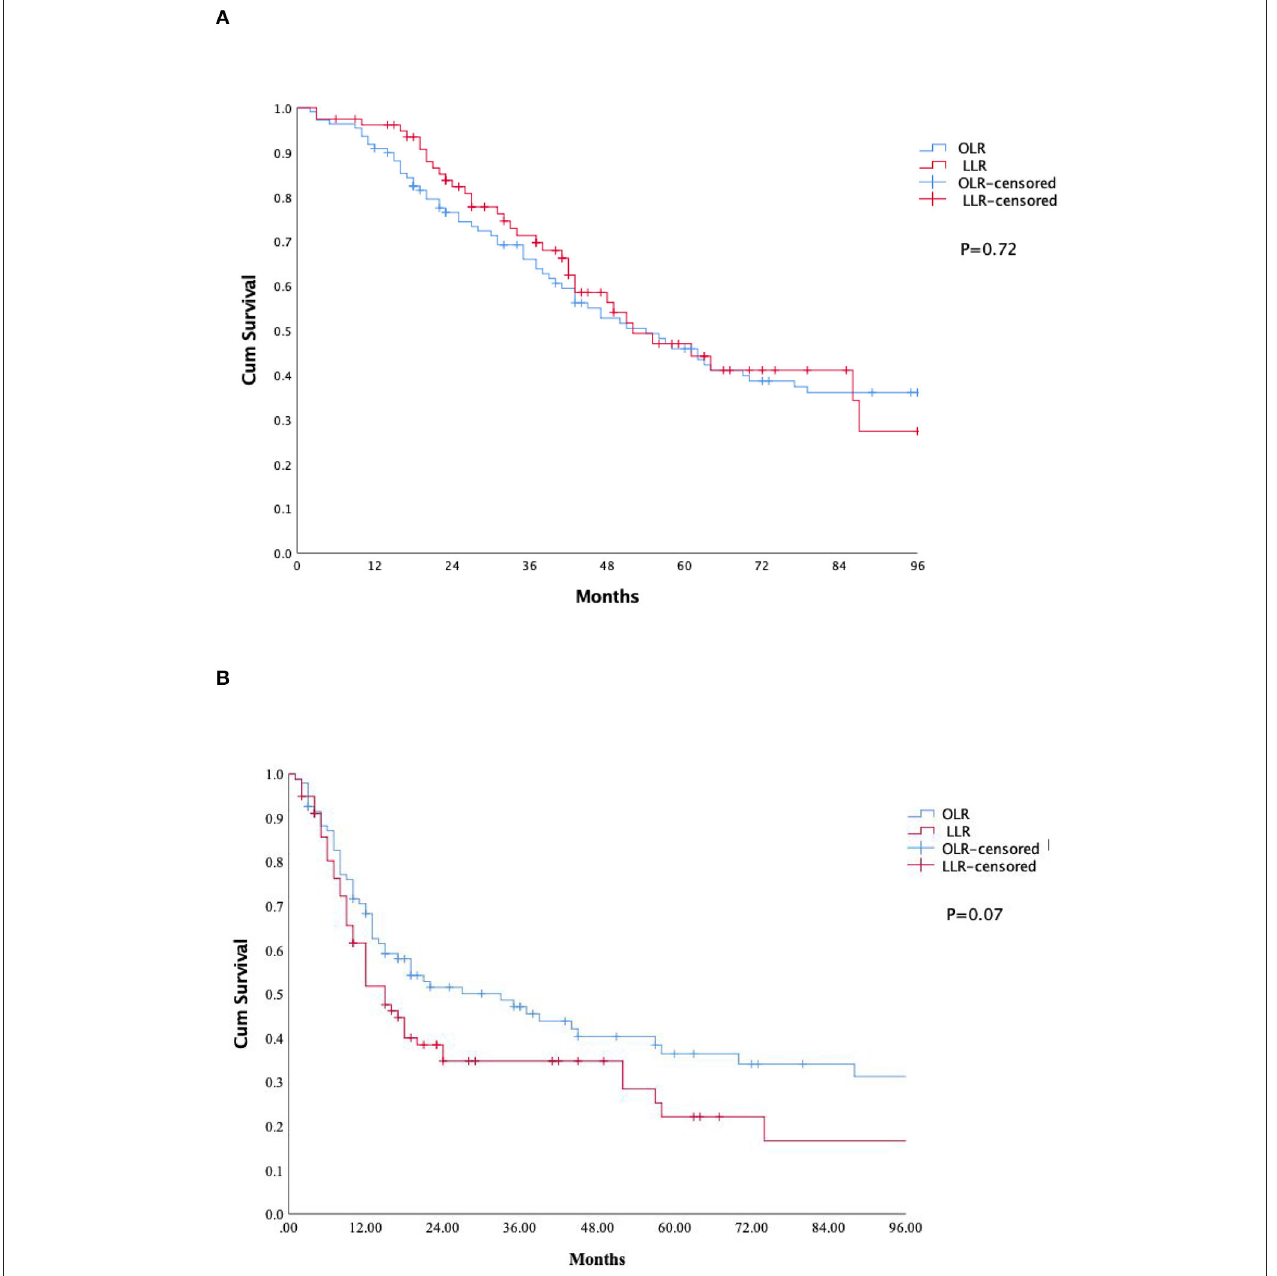
FIGURE 1 | Kaplan-Mayer curve survival. (A) : Overall survival. (B) : Recurrence free survival. OLR, Open liver resection; LLR, laparoscopic liver resection.